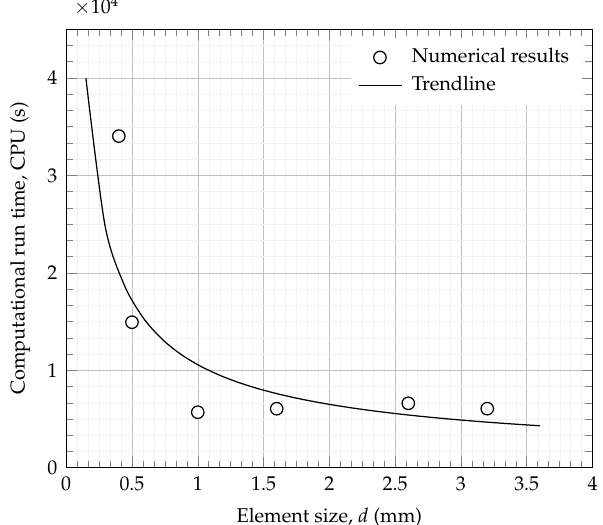
Figure 10. Computational run time (CPU) against finite element mesh element size of the honeycomb core structure.